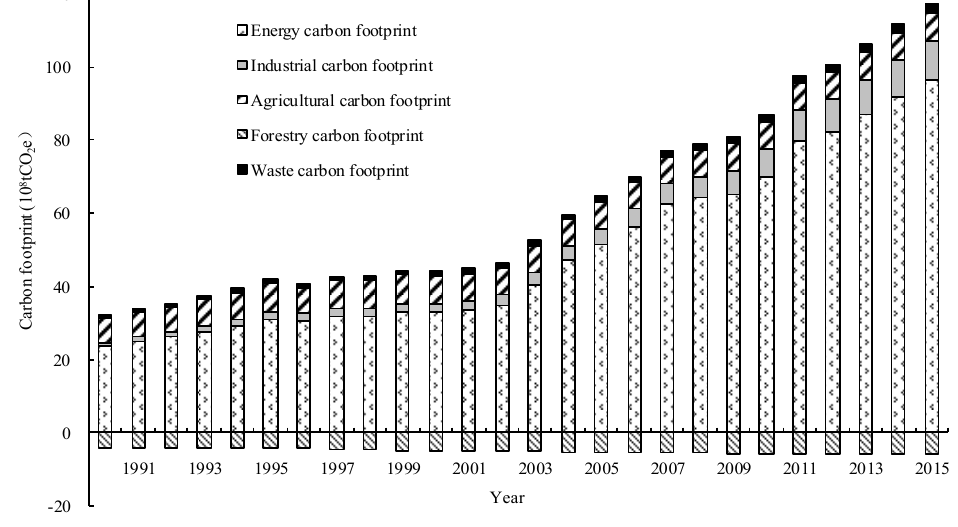
Figure 4. The component and dynamic changes of the carbon footprint.